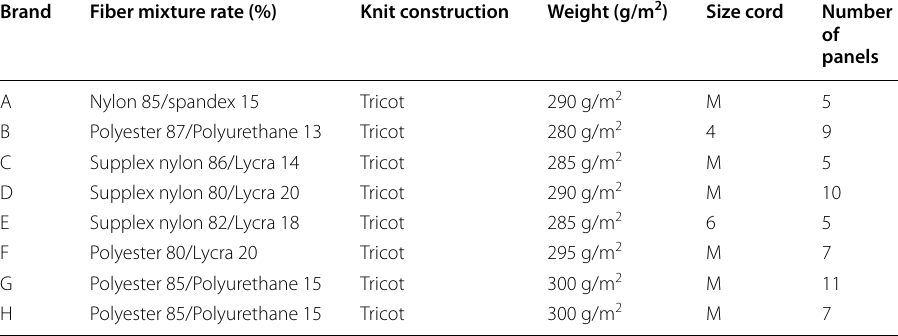
Table 1 Fiber composition of commercial leggings by brand Brand